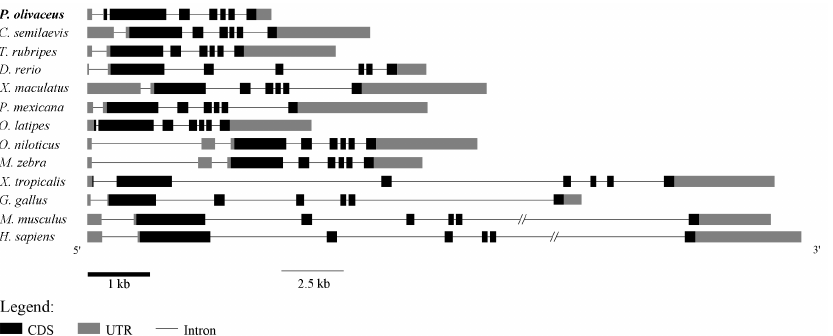
Figure 3. Gene structure analysis of GATA6. Comparisons of genomic organizations of GATA6 between teleosts and tetrapods. CDS (Coding Sequence) and UTRs are indicated by black and gray boxes, respectively, whereas introns are represented by lines.